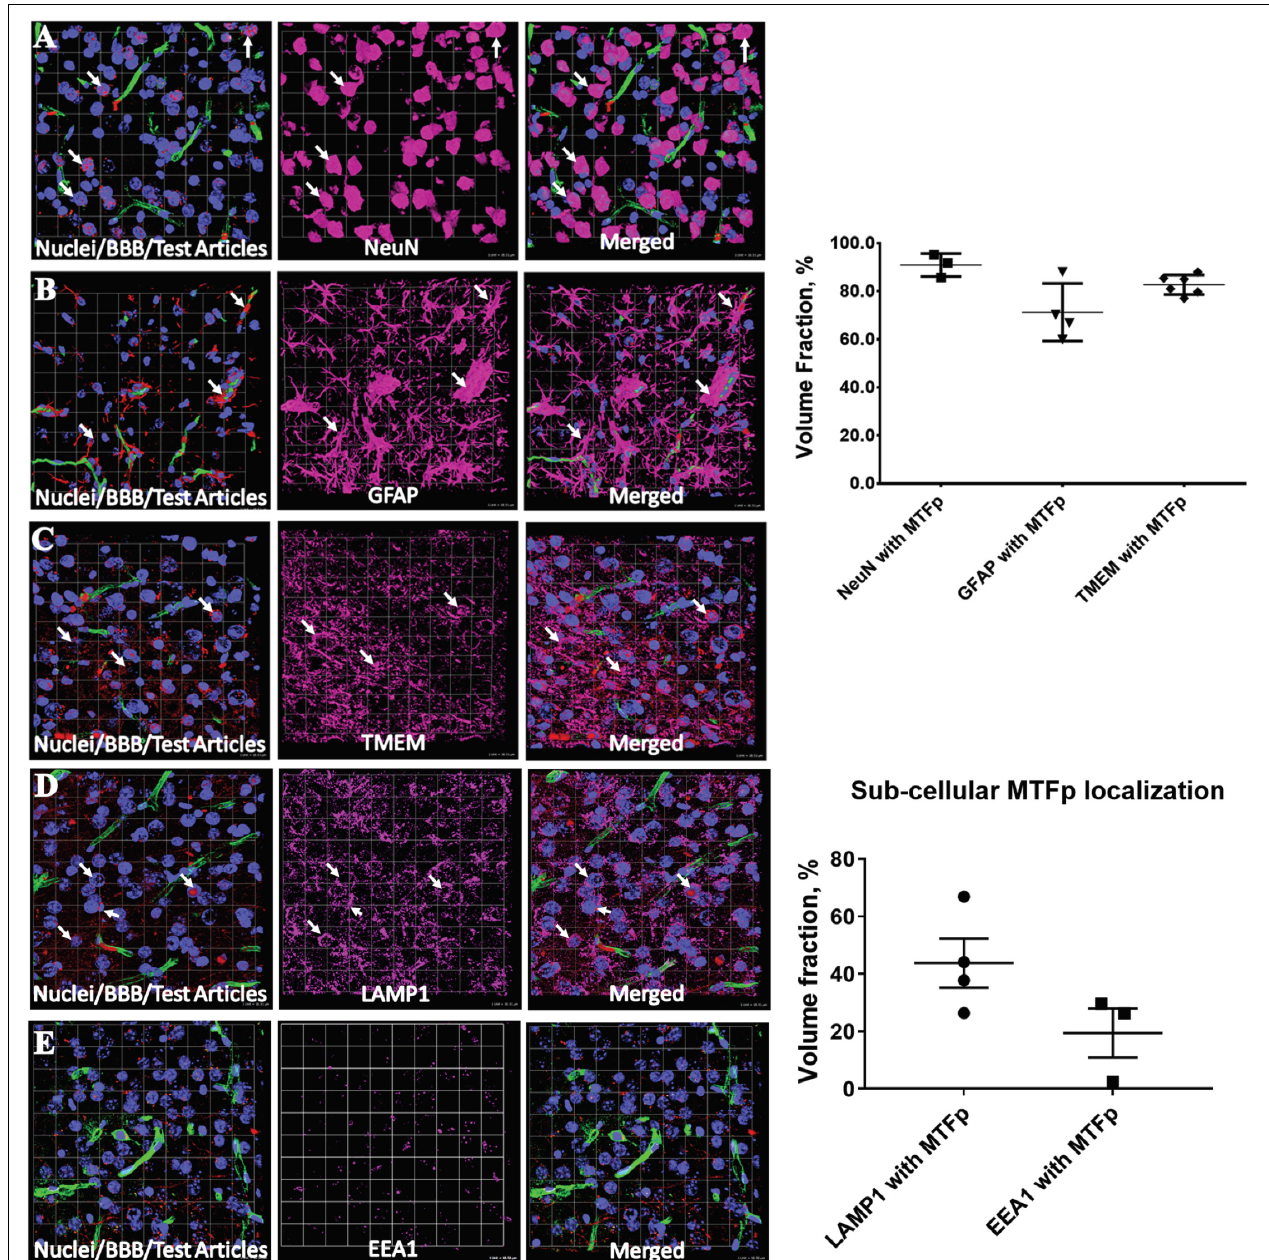
FIGURE 2 | Representative 3D confocal images showing localization of various cell types and subcellular objects with MTfp in the mouse brain sections. Cell nuclei are in blue color (DAPI) and BBBs are in green color (FITC). ( A–C) Cellular localization of MTFp and (A–E) subcellular localization of MTFp. (A) Localization of neuronal marker NeuN (Pink) with MTfp (Red), (B) localization of Astrocytes marker GFAP (Pink) with MTfp (Red), (C) localization of Microglia marker TMEM (Pink) with MTfp (Red), (D) localization of Lysosomal marker LAMP1 (Pink) with MTfp (Red), (E) localization of Endosomal marker EEA1 (Pink) with MTfp (Red). White arrows indicate co-localization of MTfp (red) and cells (pink). The graphs represent the extent of localization of various cell types and subcellular objects with MTfp in the CNS as a percentage of fluorescence volume fraction. Each animal is presented as an individual data point in the graph with the error bars indicating mean ± SEM.